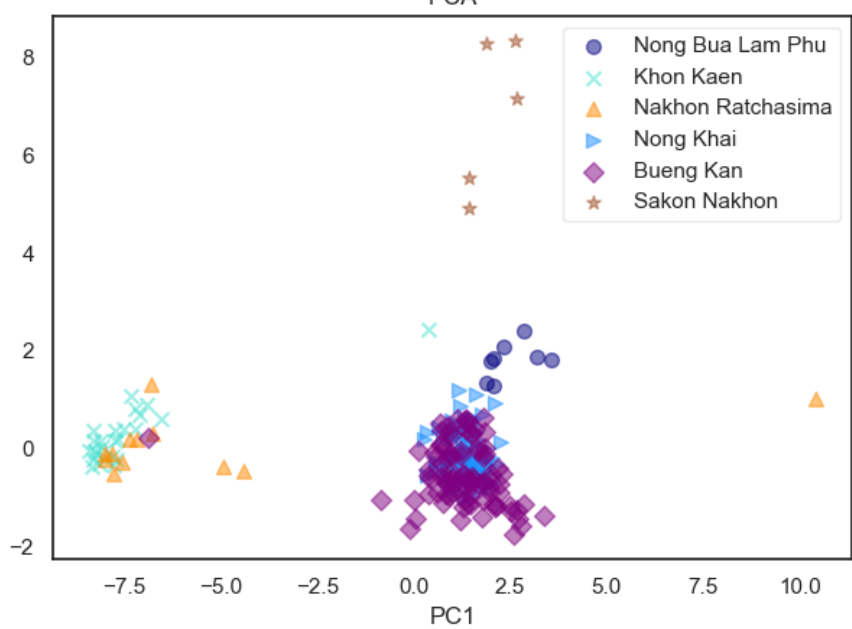
Th-232 in sand samples is much lower than the world